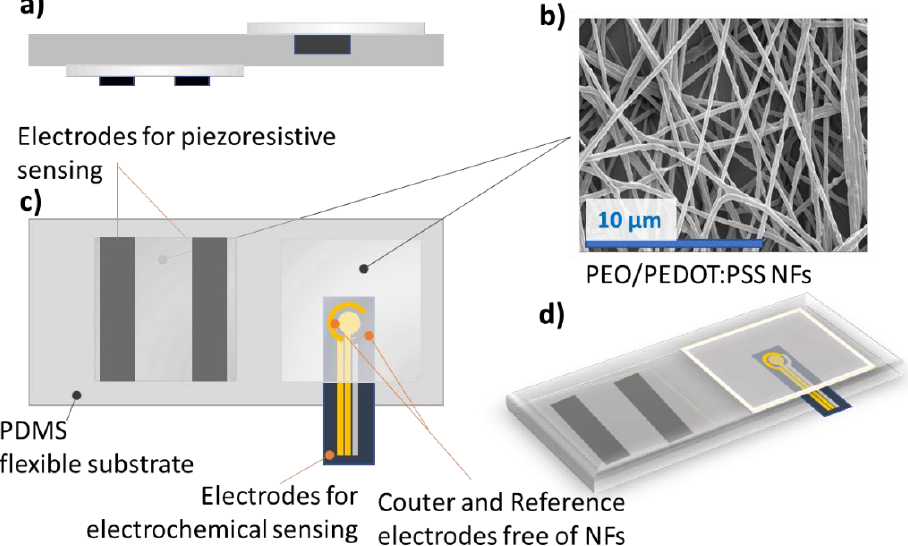
Figure 2. Design of the NFs pH-Flex Sensor. ( a ) cross view, ( b ) FESEM of the PEO/PEDOT:PSS crosslinked NFs, ( c ) top view of the device, where the position of counter and reference electrode is highlighted and ( d ) 3D view.